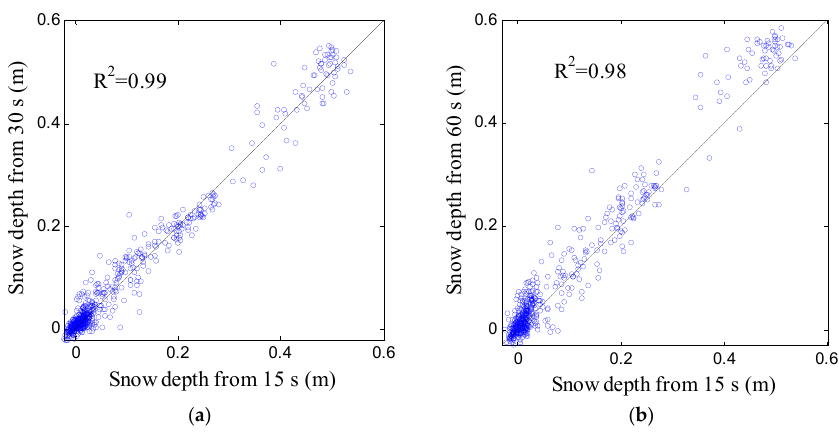
Figure 16. Comparison of snow depth estimations from different sampling rates of 15 s, 30 s and 60 s at AB39. ( a ) Correlation between 15 s and 30 s; ( b ) Correlation between 15 s and 60 s.